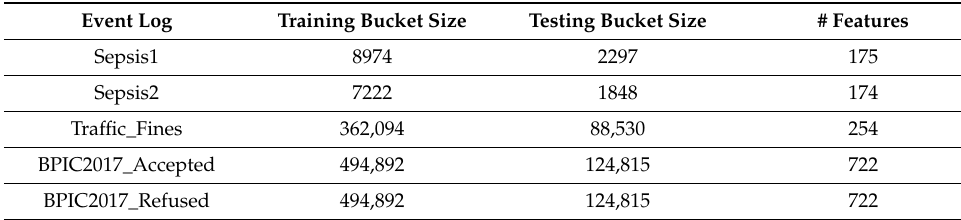
Table 5. Statistics after applying single-aggregation to the event logs.